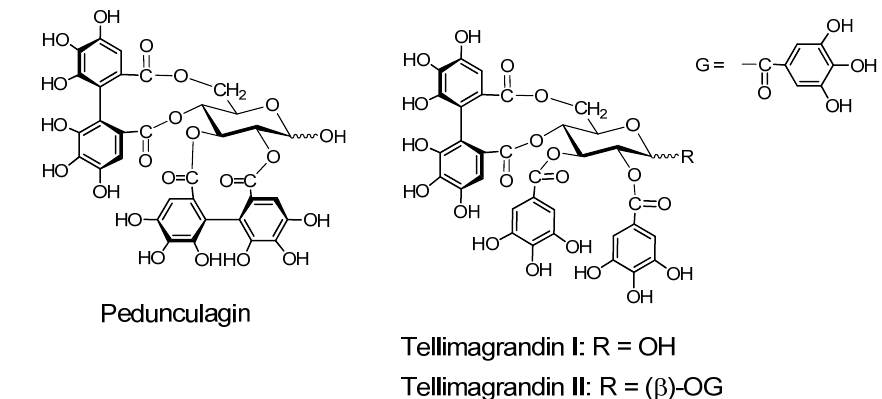
Figure 3. Ellagitannins and oxidized